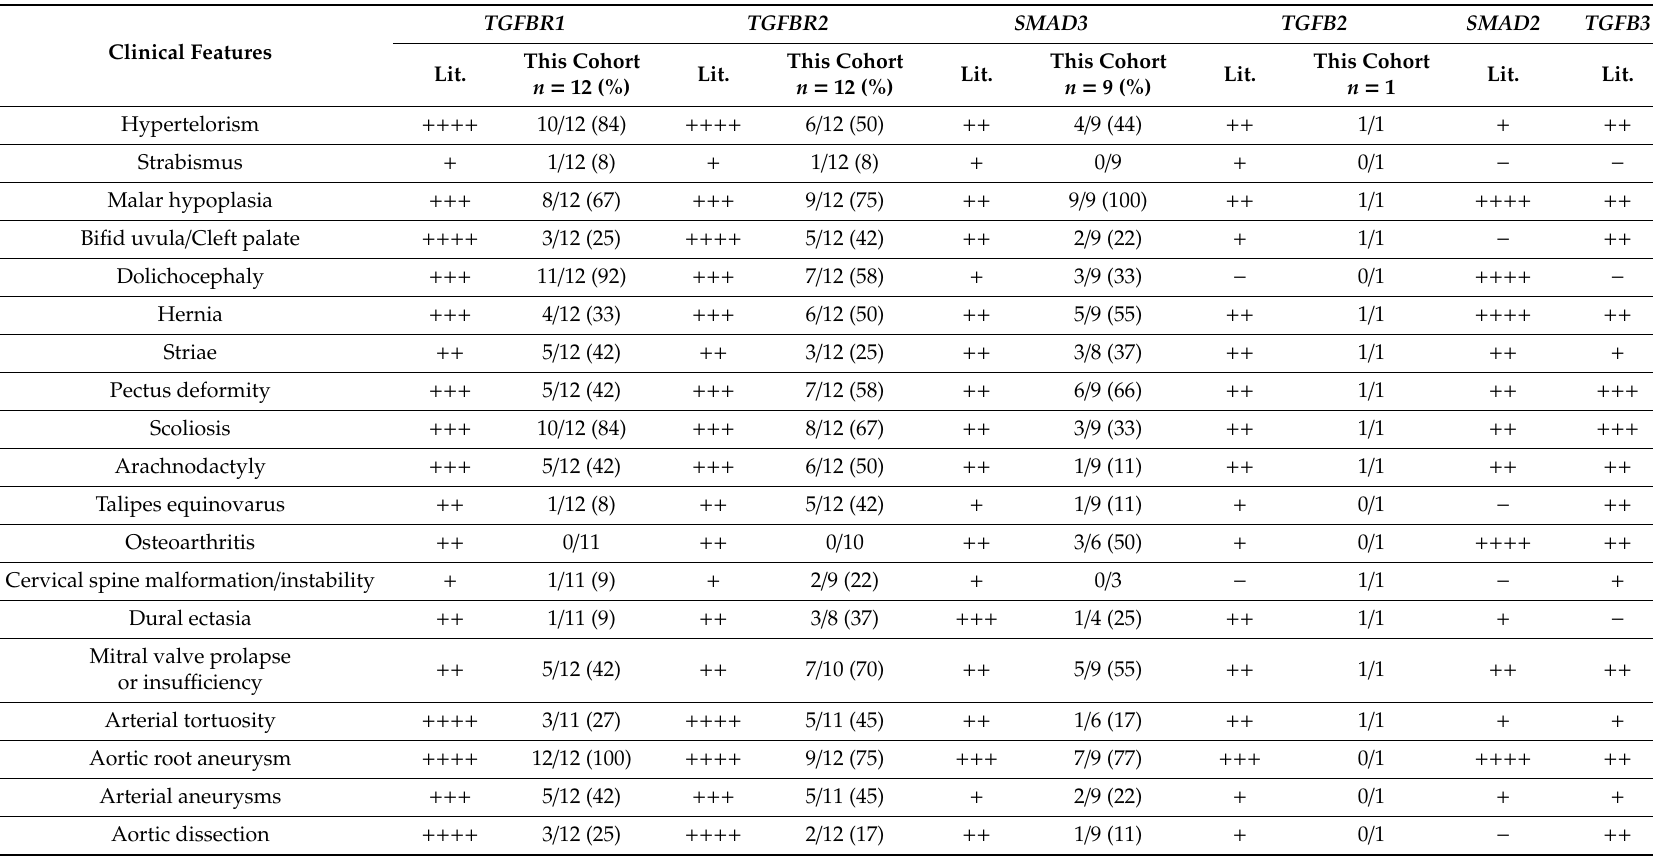
Table 1. Comparison of the clinical features observed in previously reported and LDS patients described in this cohort for each distinct